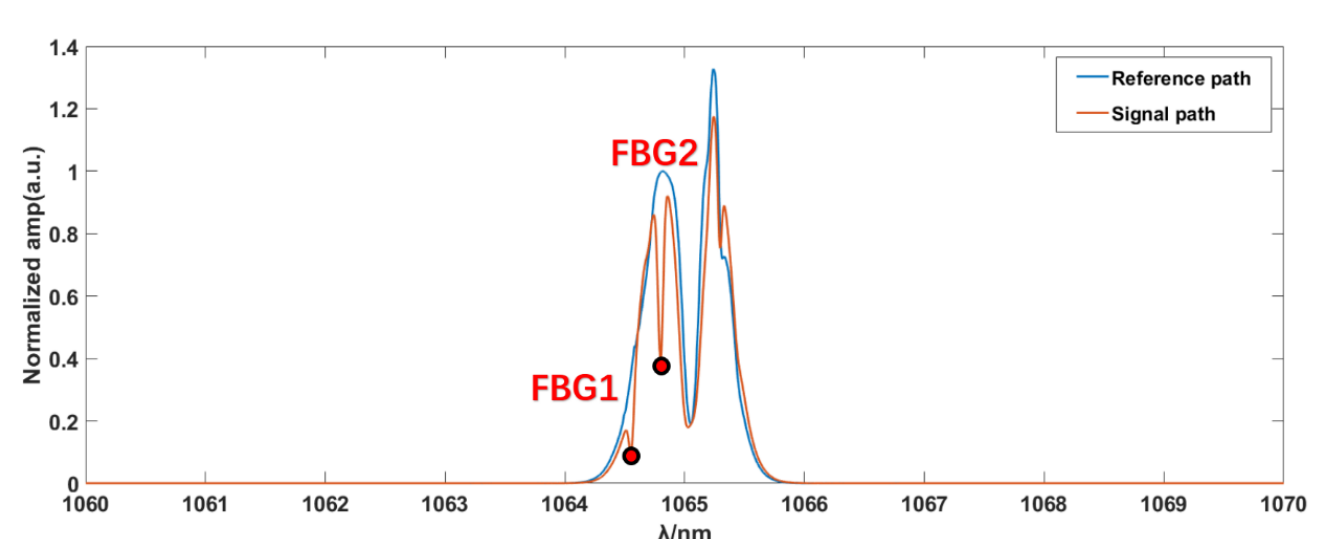
Figure 3. Optical spectra of the reference path (blue) and signal path (red).